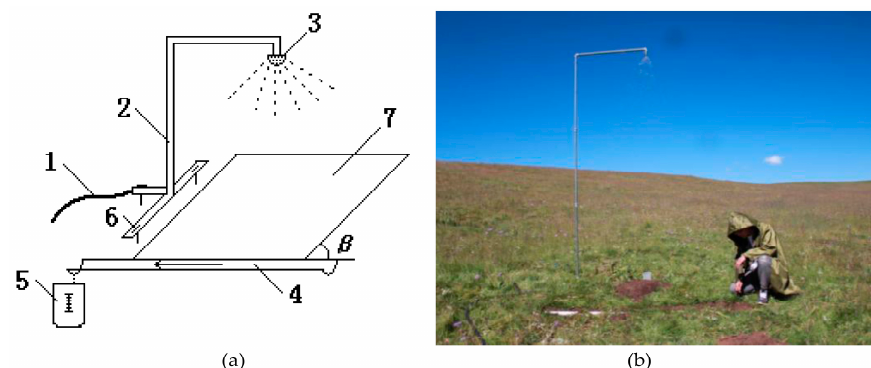
Figure 5. A schematic diagram of the precipitation simulator ( a ) and its deployment in the field ( b ): Table 1. Impact intensity of natural and simulated rainfall on the soil surface per second. 1. Water delivery pipe; 2. Support tube; 3. Solid umbrella sprinkler; 4. Guide tank; 5. Beaker; 6. Ground anchor; 7. Plots; β --Slope gradient.